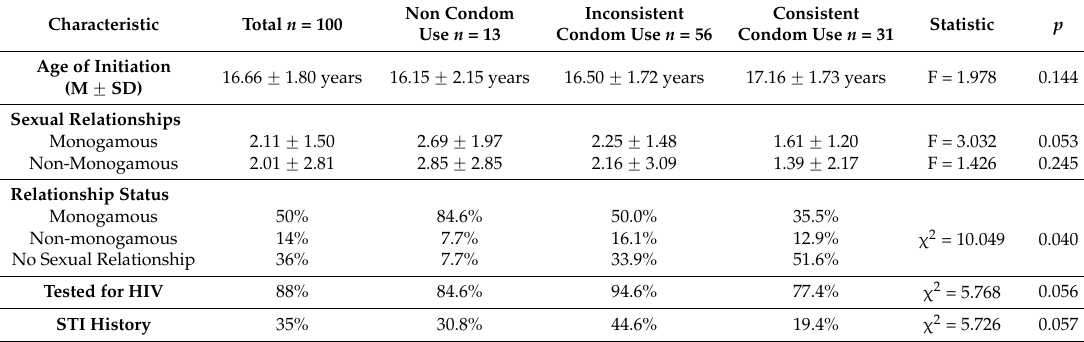
Table 2. Frequency of condom use and sexual history characteristics of minority college